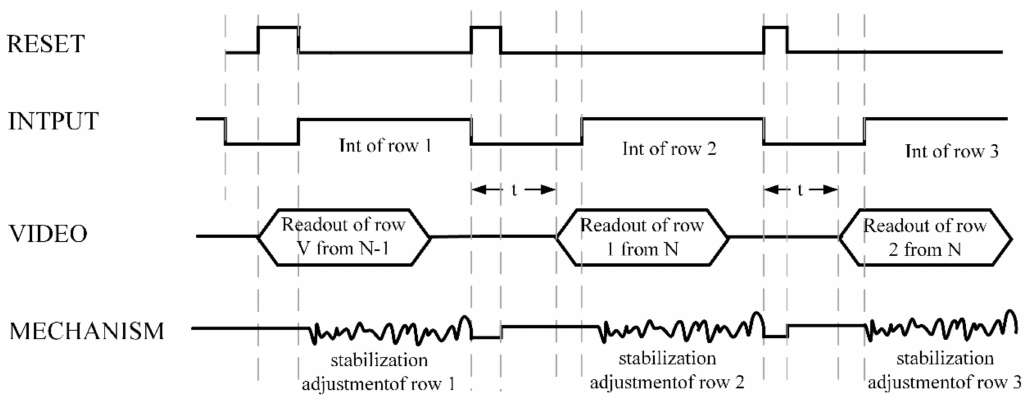
Figure 22. Working sequence diagram of an infrared imaging